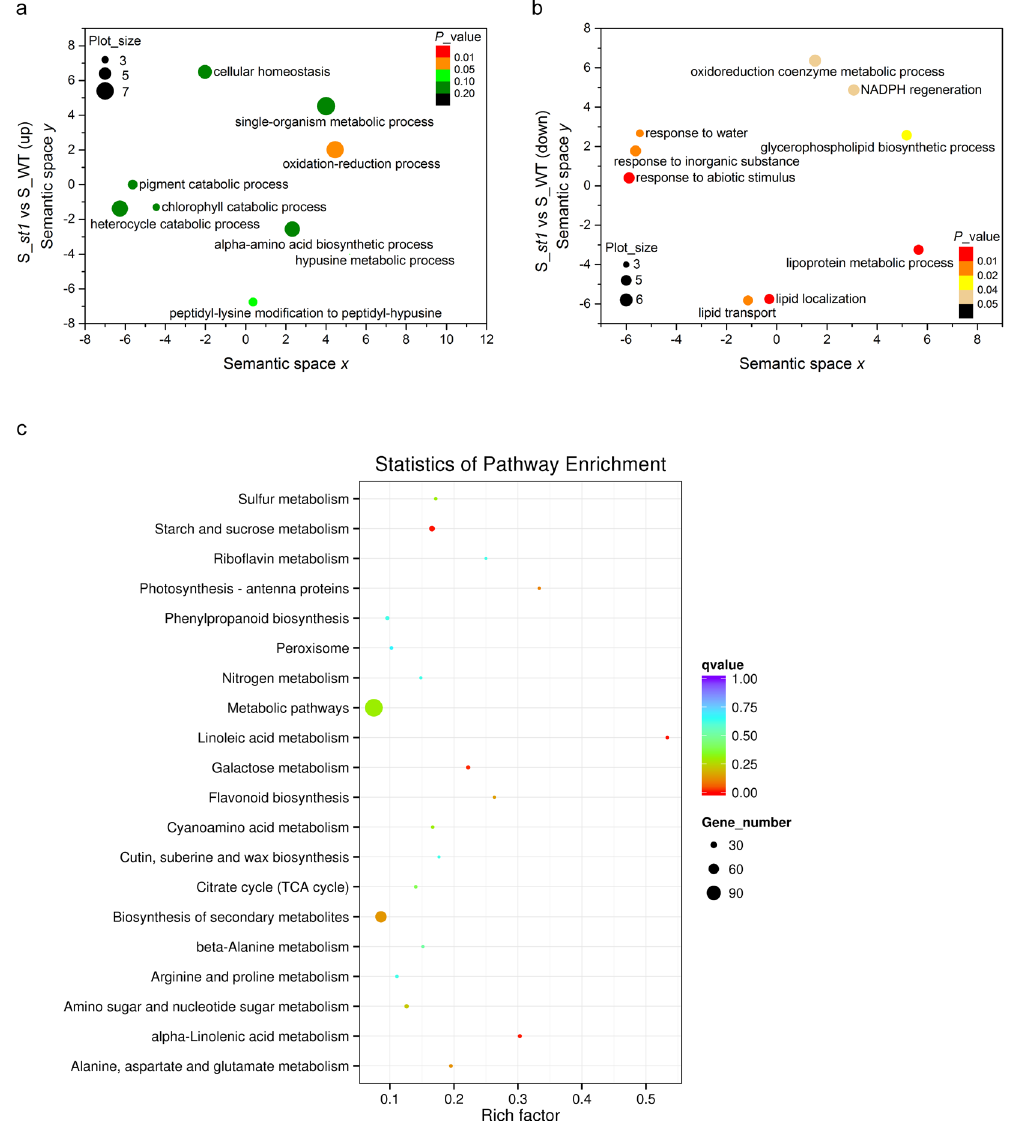
Figure 5. GO enrichment and KEGG pathway analysis. The top ten GO terms enriched in S_ st1 vs S_WT DEGs, determined based on the lowest p values, were analyzed by REVIGO. ( a , b ) The enriched GO terms from the REVIGO analysis for up-regulated ( a ) and down-regulated ( b ) genes in the S_ st1 vs S_WT comparison group. Circles in closer proximity have more closely related GO terms. The size of the circles indicates the number of child GO terms. The color of the circle represents the significance of the enriched GO terms. ( c ) KEGG pathways enriched in S_ st1 vs S_WT up-regulated genes. The abscissa represents the richness factor reflecting the proportion of DEGs in a given pathway. The number of DEGs in the pathway is indicated by the circle area, and the circle color represents the range of the corrected P